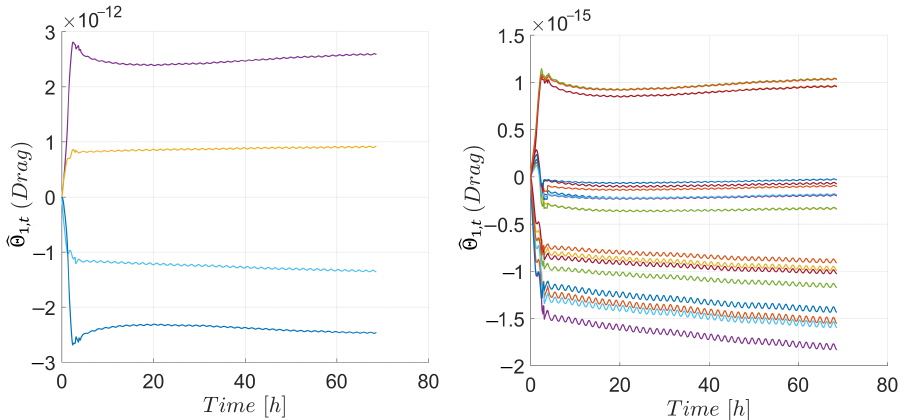
Figure 11. Parameter estimates from the attitude controller associated with the aerodynamic drag of the target. Components (cid:98) B 1 (cid:98) C D , j of (cid:98) Θ 1 , t with j = 1,2,3,4 ( left ), remaining components of (cid:98) Θ 1 , t ( right ).